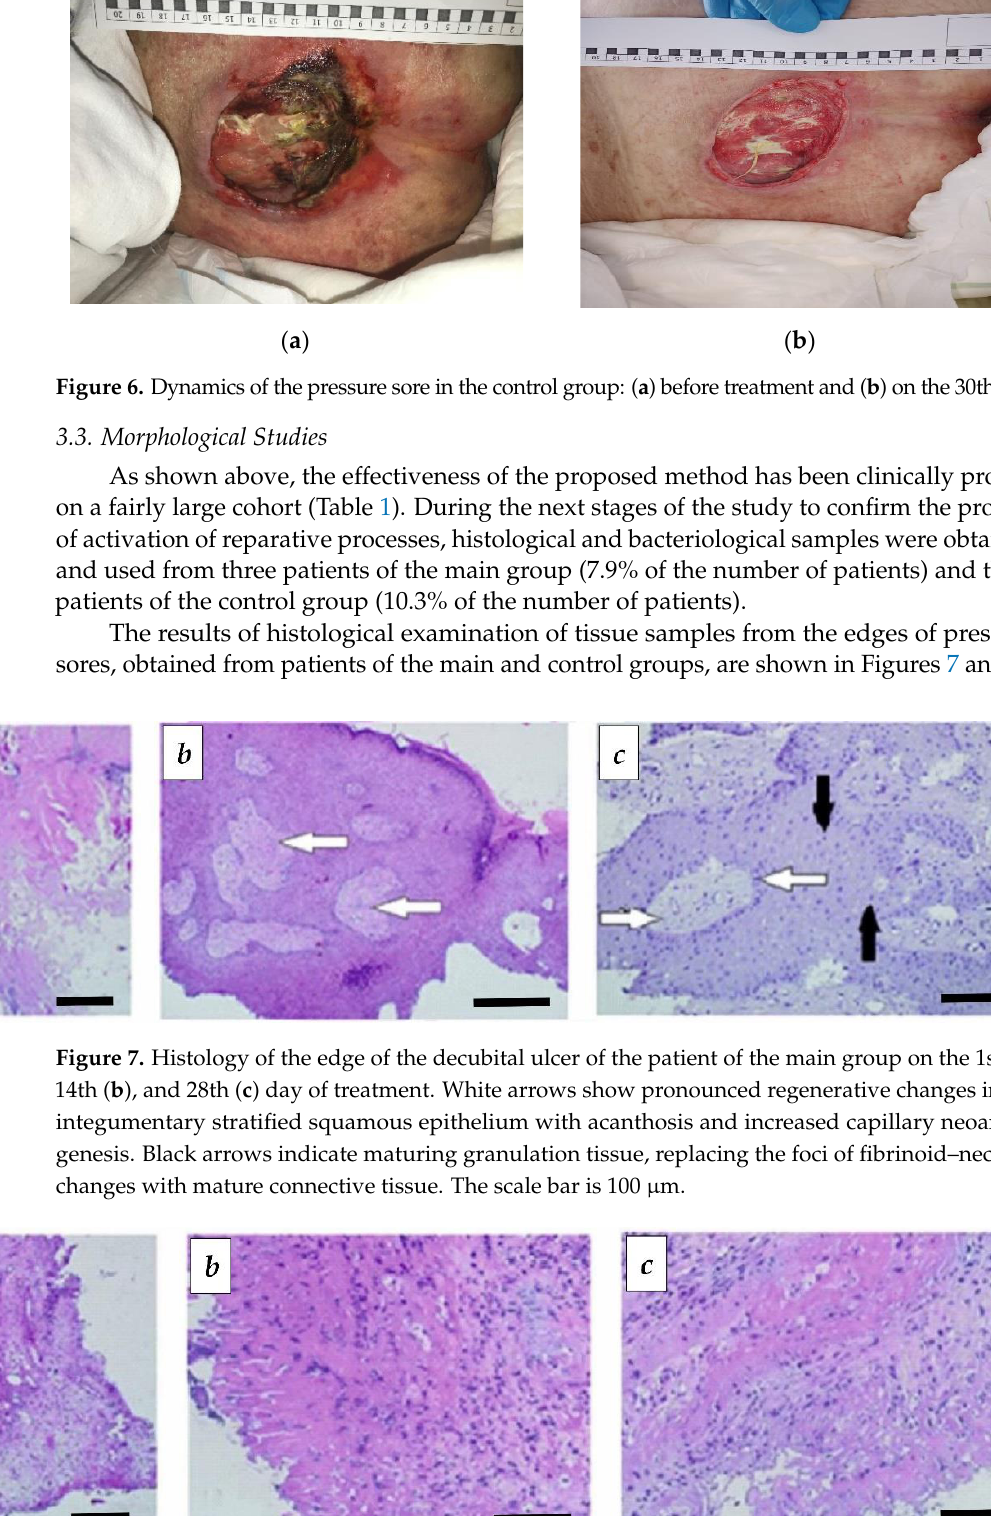
Figure 5. Dynamics of the pressure sore in the main group: ( a ) before treatment and ( b ) on the 30th day.